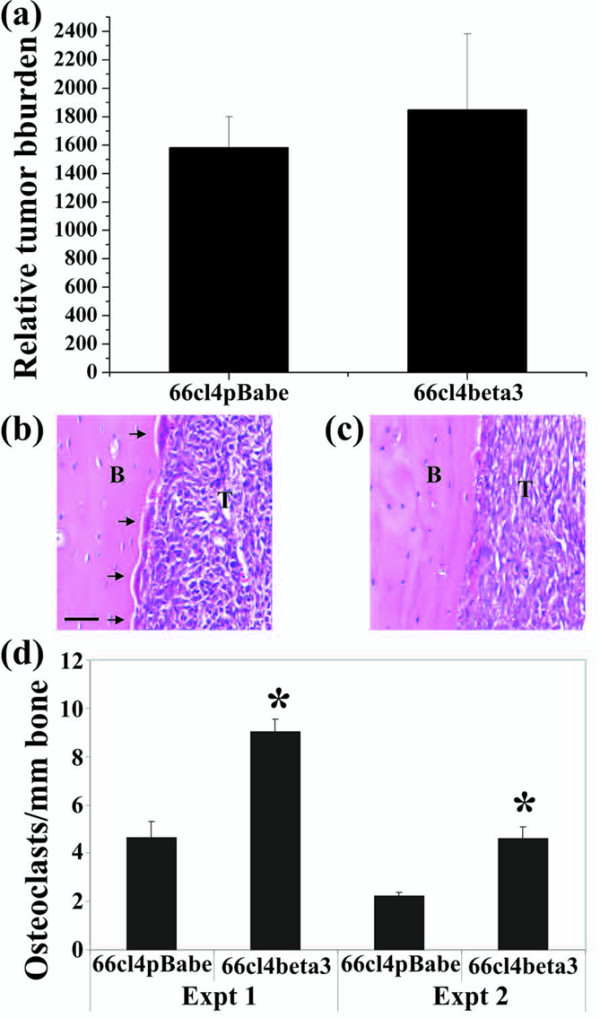
Tumor αvβ3 integrin enhances osteoclast recruitment and osteolysis following intratibial injection of tumor cells. (a) The relative tumor burden was measured by real-time quantitative PCR 14 days following direct intratibial injection of 66cl4pBabe and 66cl4beta3 cells. Representative H&E-stained sections through tibias injected with (b) 66cl4beta3 or (c) 66cl4pBabe cells. Osteoclasts are marked with arrows. B, bone; T, tumor. Scale bar = 50 μm. (d) Serial sections adjacent to those stained by H&E were stained for tartrate-resistant acid phosphatase (TRAP) activity, and the active osteoclasts (TRAP-positive) present per millimeter of bone in tibias injected with either 66cl4beta3 or 66cl4pBabe cells were counted. Results of two independent experiments are shown. n = 4 mice/group per experiment *P < 0.001.